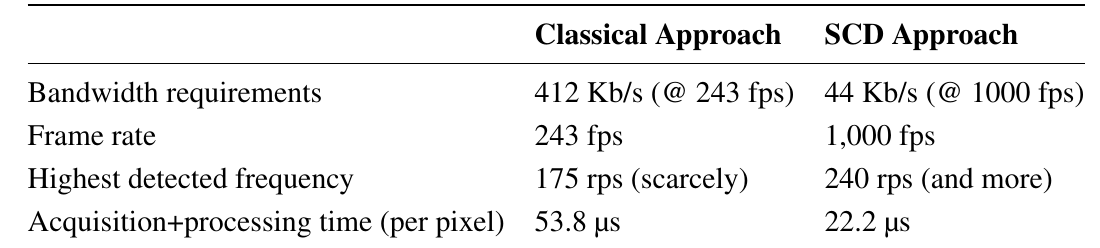
Table 1. Classical vs . SCD comparison